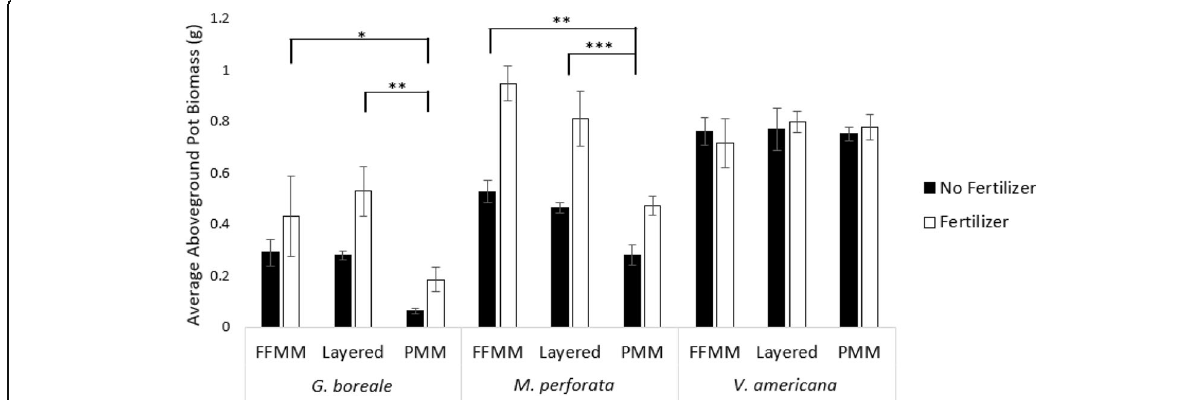
Fig. 1 Average aboveground plant biomass per pot for pure species pots across fertilizer and soil treatments. Bars indicate standard error, and asterisks represent p values generated from post hoc analysis (Tukey ’ s test) that compares subset species across soil treatments (*** p <0.001, ** p <0.01, * p